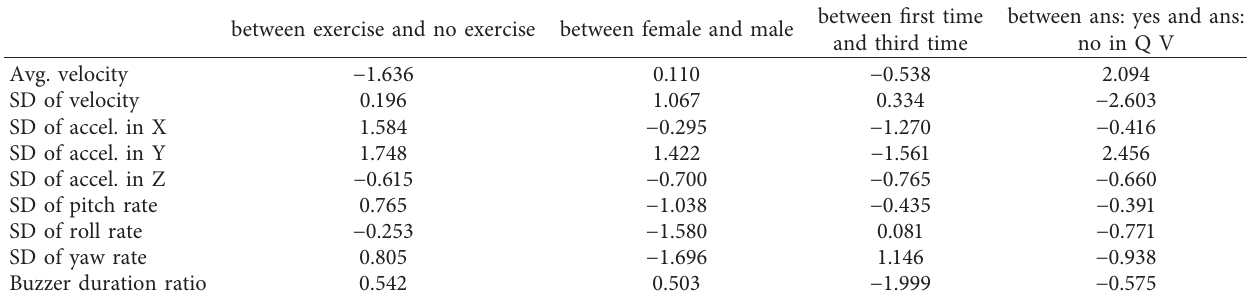
between first time and third